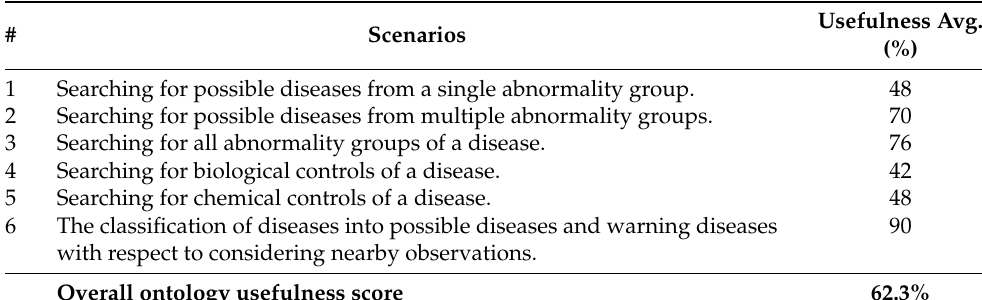
Table A2. Usefulness of inferred knowledge in six scenarios, evaluated by senior agronomists.